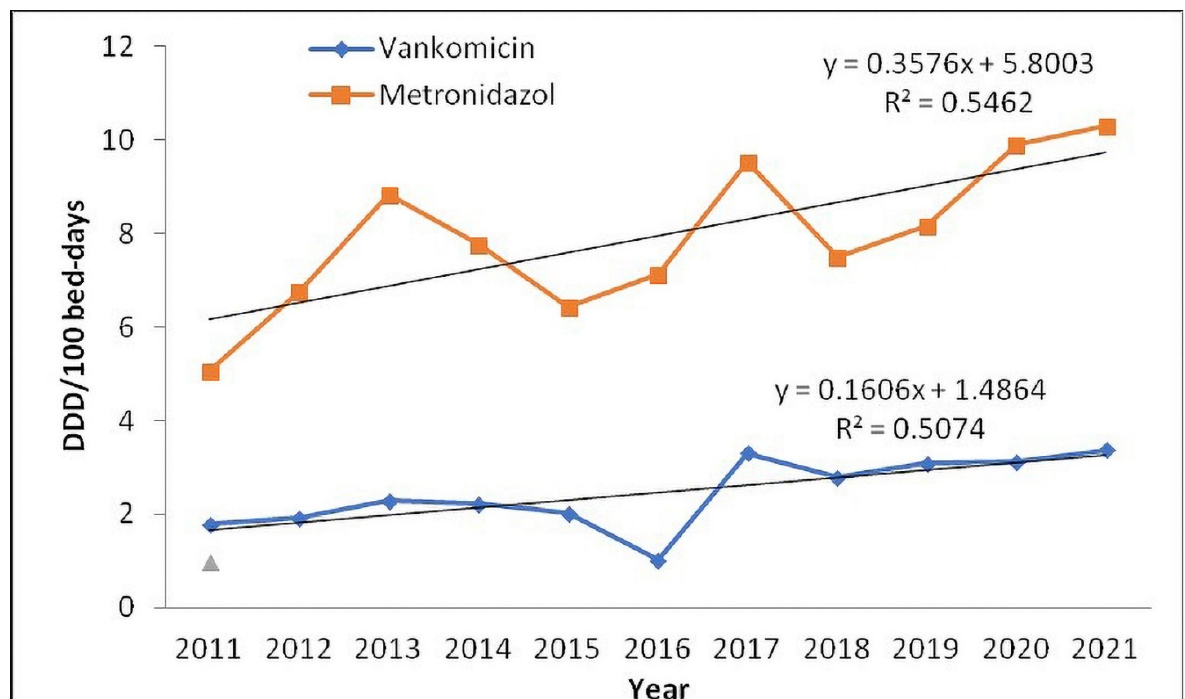
Figure 4. Trend of vancomycin and metronidazole consumption in defined daily doses (DDD) per 100 bed-days from 2011 to 2021.